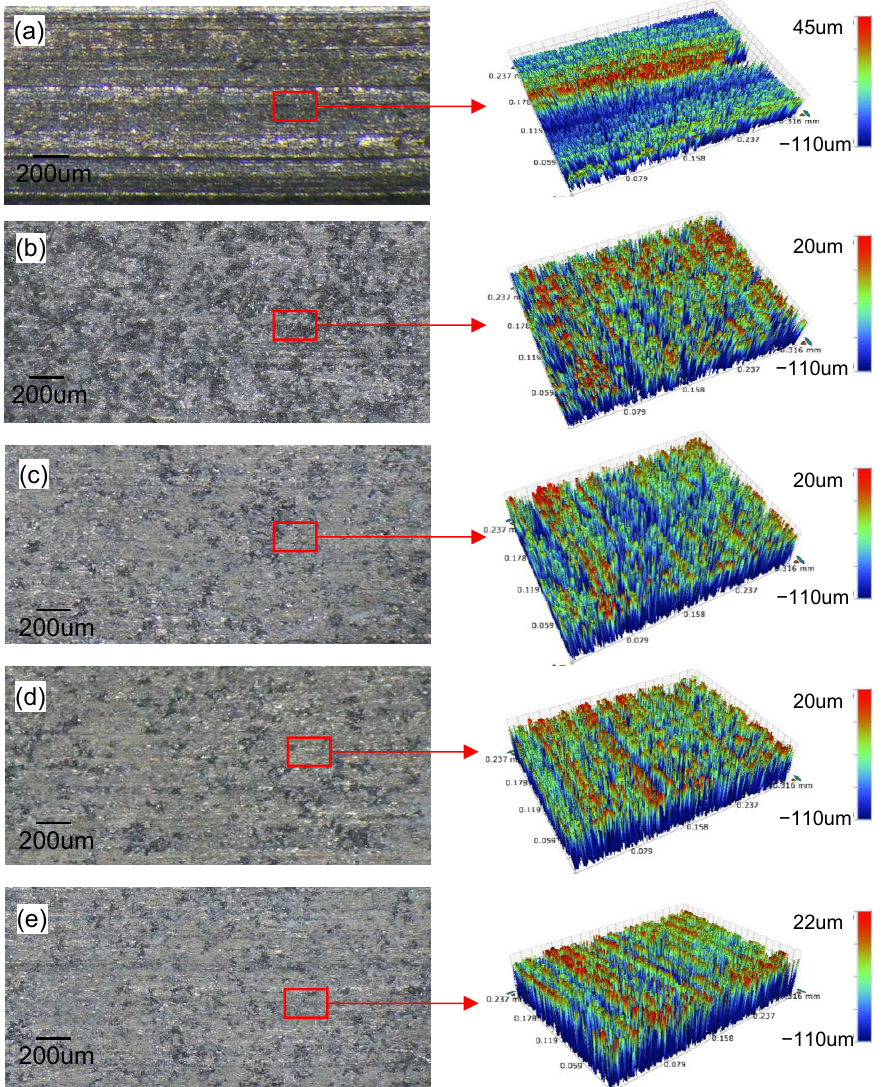
Figure 8. Comparison of machined surface and topographies: ( a ) GM; ( b ) GE/DM; ( c ) ZUE/DM; ( d ) XUE/DM; ( e )